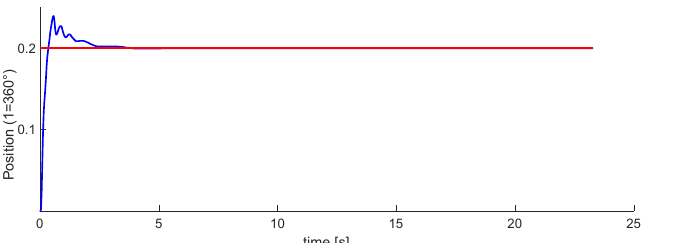
Figure 20. Experimental results for the first DoF. The Setpoint signal is colored in red, control signal in